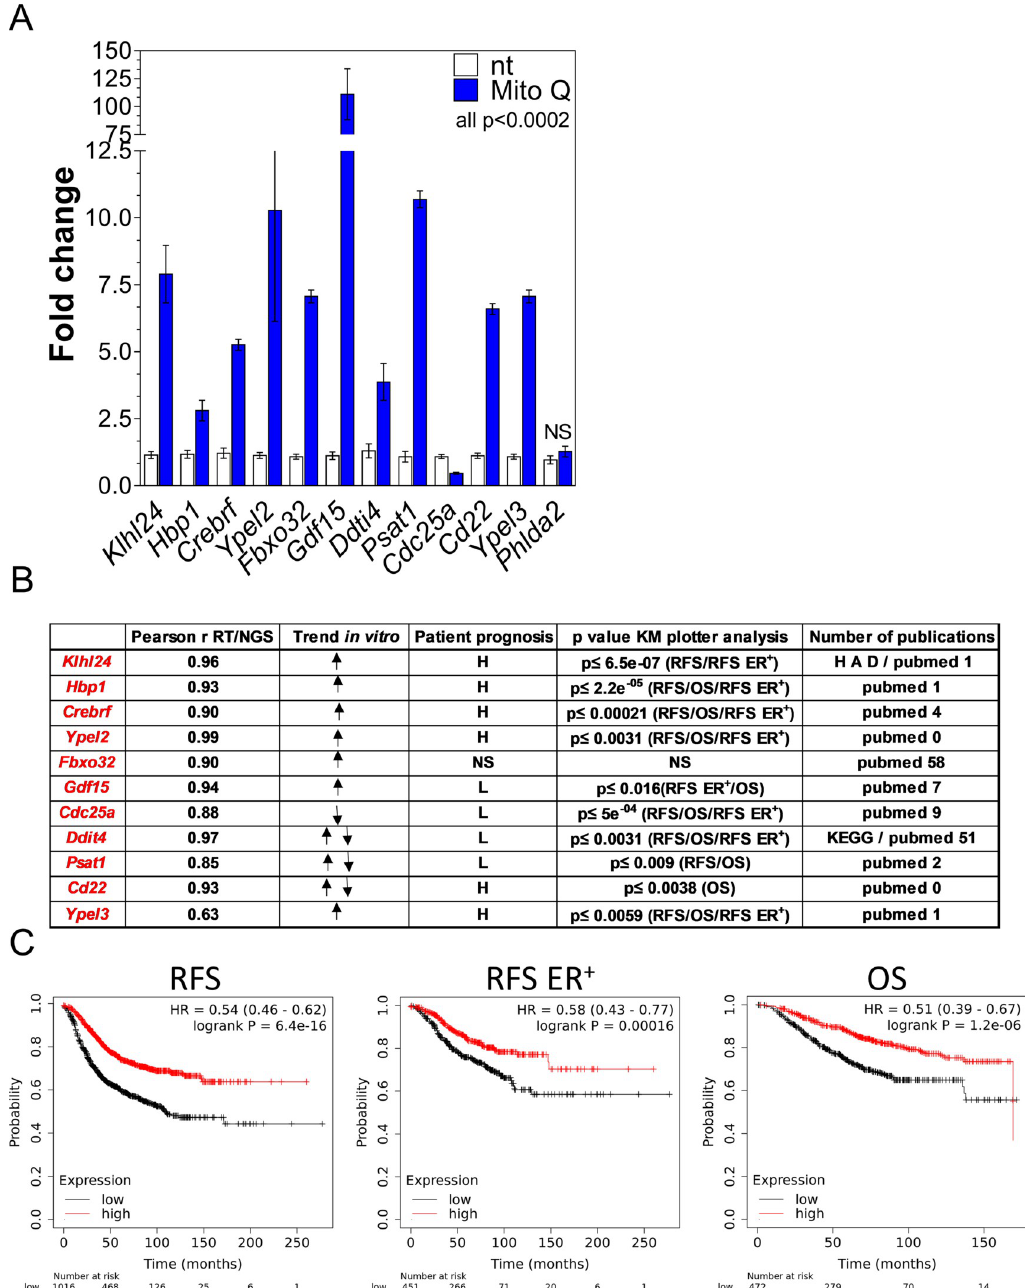
Fig 4. Testing the autophagy mRNA signature in an independent cohort of mRNAs in vitro and in a database of samples from breast cancer patients. A) MDA-MB-231 cells were treated with 5 μ M mitoquinone (Mito Q), a well characterized inducer of autophagy, for 16 hours. Relative expression levels of the mRNAs from the autophagy signature were verified by Q-RT-PCR and depicted in the graph as fold change upon untreated levels. B) The table lists: Pearson r value of correlation between RNA Q-RT-PCR data and sequencing data; trend of the expression of the mRNA after the drug treatments where " means upregulation, # means downregulation and "# means upregulated or downregulated depending on the drug/cell line; correlation with better patient prognosis in different outcomes such as relapse-free survival (RFS), overall survival (OS), relapse-free survival in ER + patients only (RFS ER + ) with high levels of mRNA expression (H) or low levels of mRNA expression (L); NS = non- significant p � 0.05; Higher p value for the outcome correlations described in the previous column; Number of publications on PubMed with the term search “autophagy and mRNA gene symbol” as of April 2021 and the presence of the mRNA in the human autophagy database (HAD) or in the Kyoto Encyclopedia of Genes and Genomes (KEGG) as associated with an